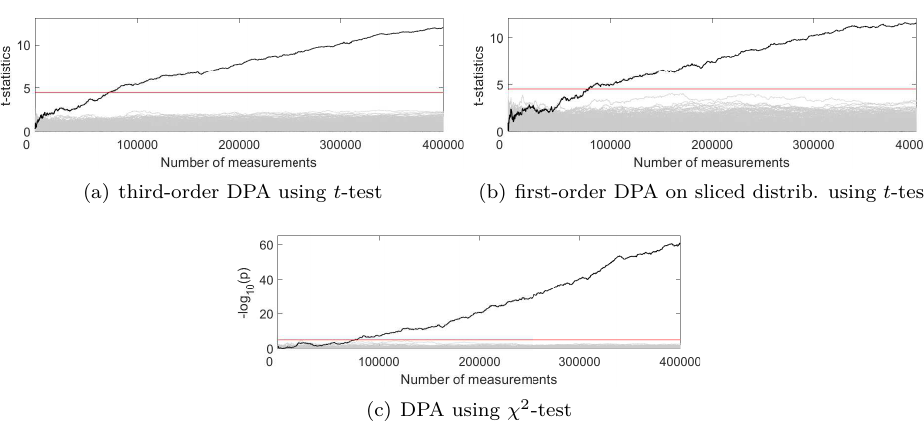
Figure 16: DPA attacks using different distinguishers on an Sbox output bit of an AES threshold implementation in 65 nm technology, recorded at 90 ◦ C and 1 . 6